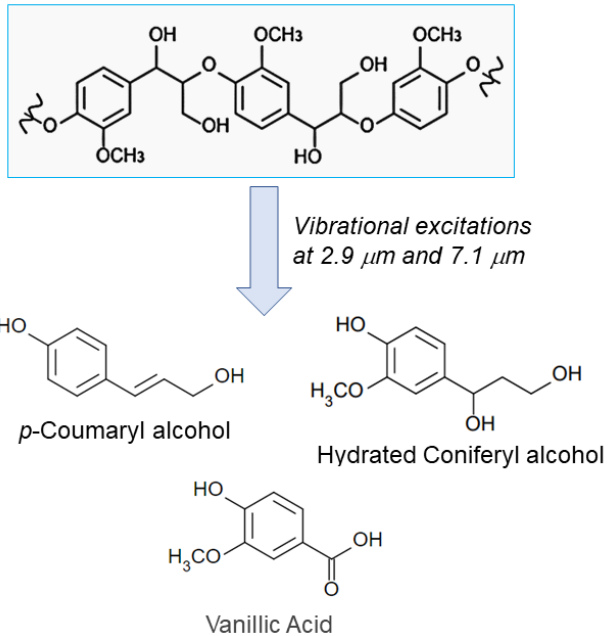
Figure 5. Degradation of lignin by vibrational excitation at 2.9 µ m and 7.1 µ m. Three lignin monomers were identified by the ESI-MS and 2D NMR analyses after the IR-FEL irradiations. Together with the results on cellulose and lignin, the IR-FEL irradiation technique is promising for the degradation of woody carbohydrates to produce constituent